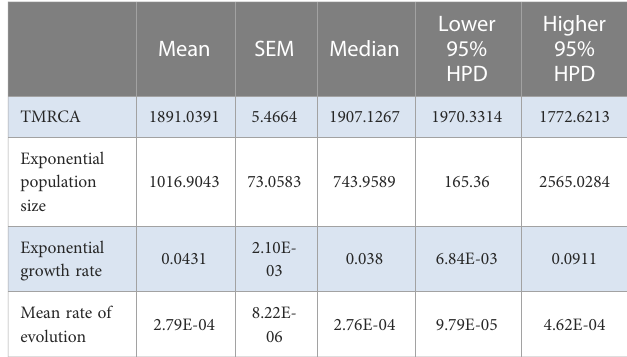
TABLE 8 Relevant estimates from the Bayesian analysis for the Spanish AMV population.